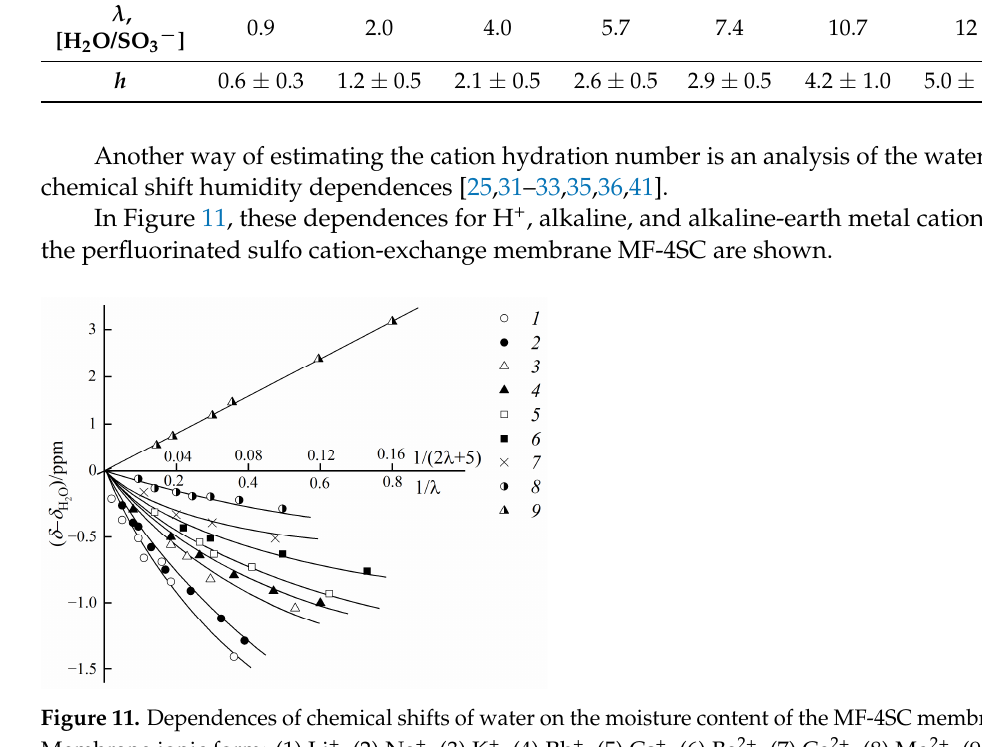
Figure 11. Dependences of chemical shifts of water on the moisture content of the MF-4SC mem- brane. Membrane ionic form: (1) Li + , (2) Na + , (3) K + , (4) Rb + , (5) Cs + , (6) Ba 2+ , (7) Ca 2+ , (8) Mg 2+ , (9) H + (adapted from [36]).